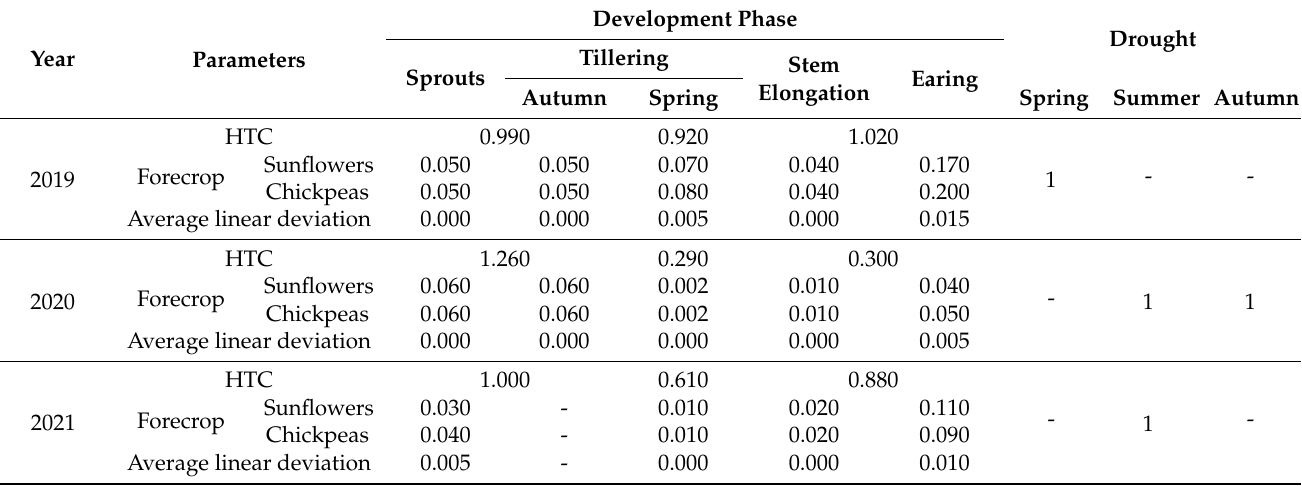
Table 8. Effect of HTC on the index of duration of interphase periods of winter wheat development (D), days (average for